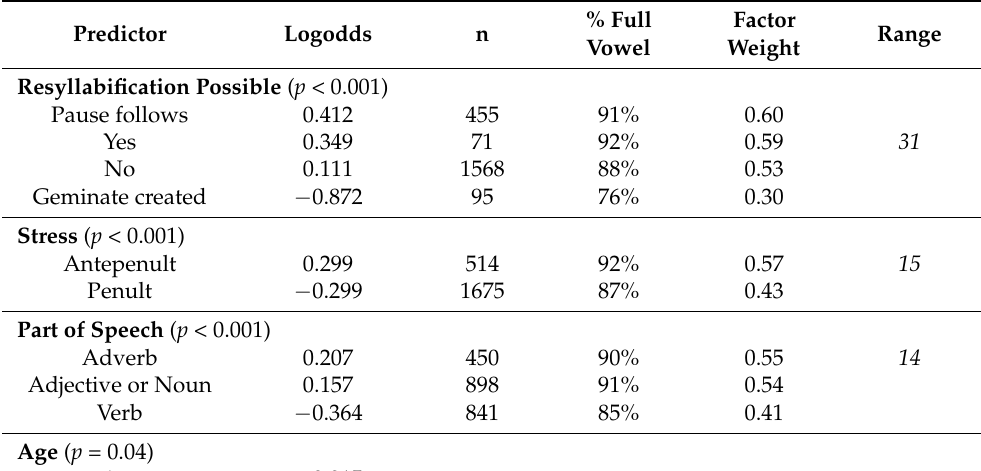
Table 3. Best-fitting mixed-effects model with Full Vowel as application value and Reduced&Deleted as non-application value, for all speakers (N = 2189).